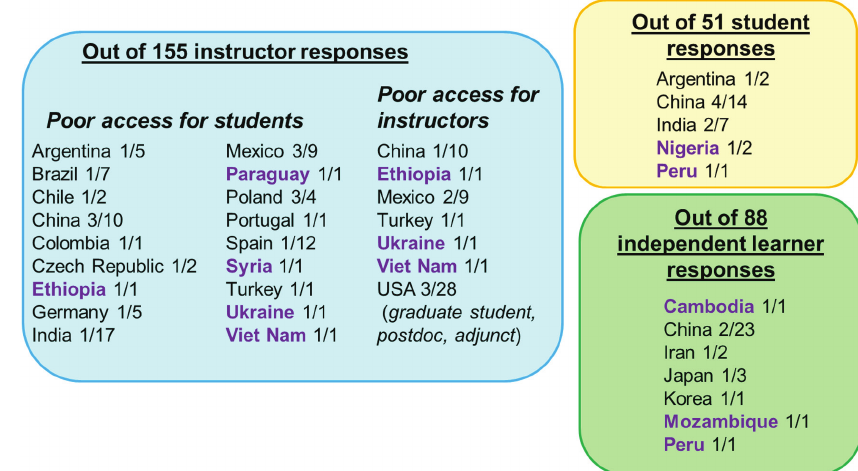
Figure 2. Between 6–20% of respondents in each category reported poor access to textbooks for themselves or their students. This was particularly a concern for respondents from least-developed countries (shown in purple) from which access Teaching Tools in Plant Biology is available through AGORA (Access to Global Online Research in Agriculture).